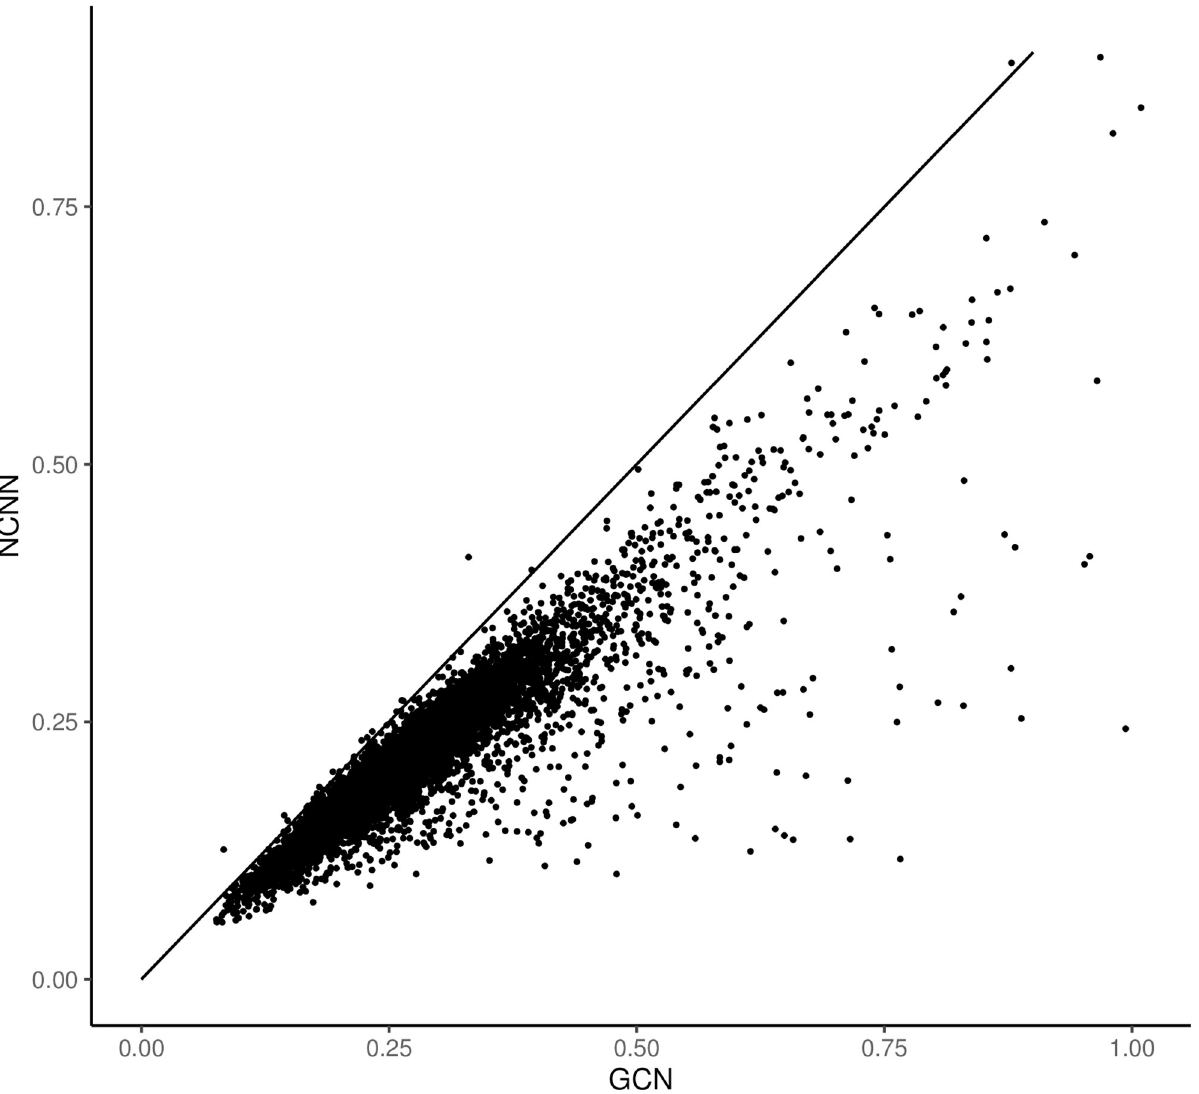
Fig 8. The comparison of mean average error of predictions on each gene in GTEx dataset. The y value is the mean average error from NCNN model on each target gene; the x value is the mean average error from GCN model on each target gene. Each dot below the diagonal means that NCNN has lower prediction error on this gene than the comparing